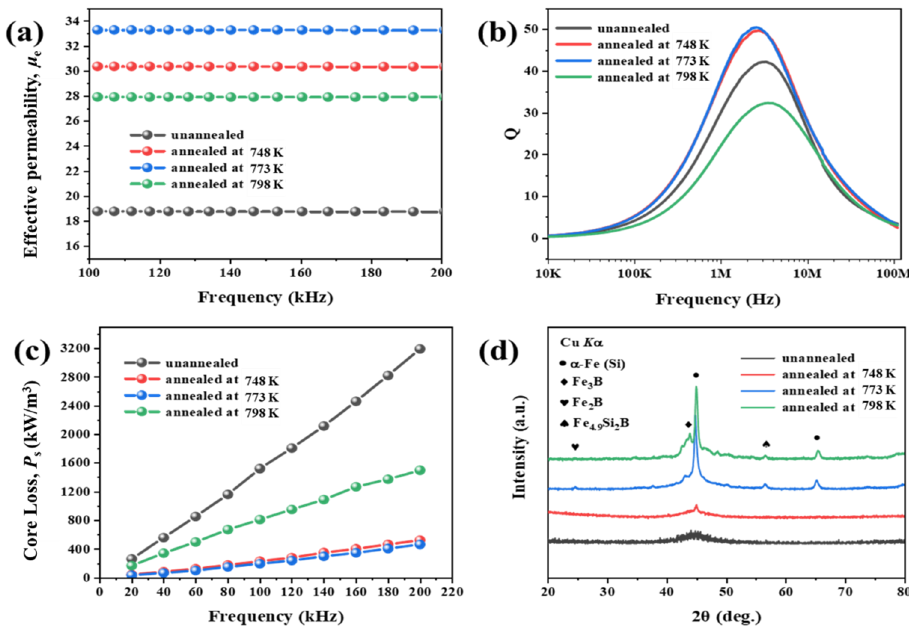
Figure 8. Frequency dependence of the ( a ) μ e, ( b ) Q , ( c ) P s , ( d ) XRD for SMCs after annealing at different temperatures.